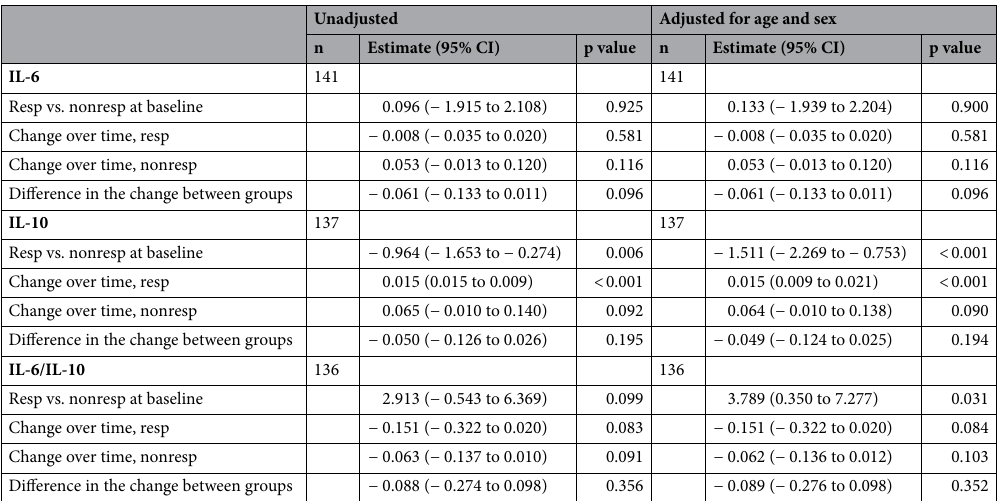
Unadjusted Adjusted for age and